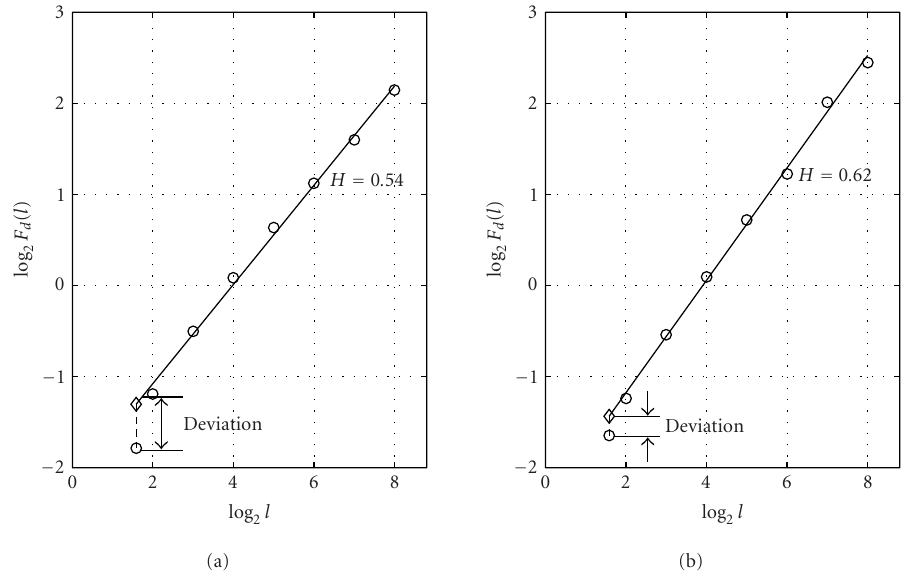
Figure 3. Representative period-3 fractal deviation (PFD) for (a) coding and (b) noncoding regions in yeast chromosome I.